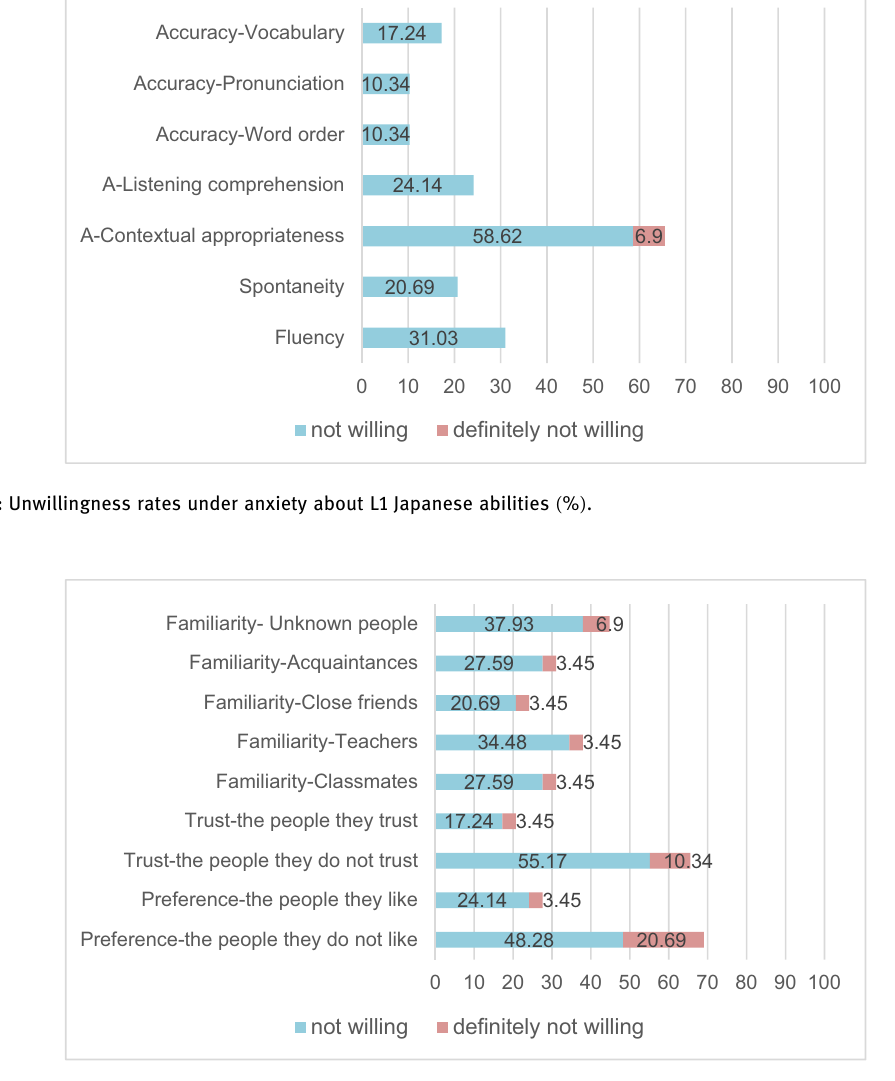
Figure 11: Unwillingness rates under anxiety about evaluation from others in L2 English ( % ) .